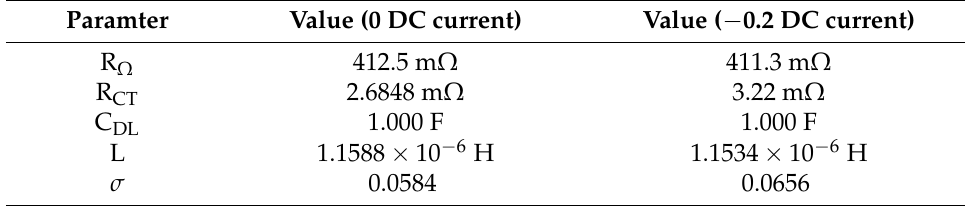
Table 2. Estimated parameters (nonlinear LS).